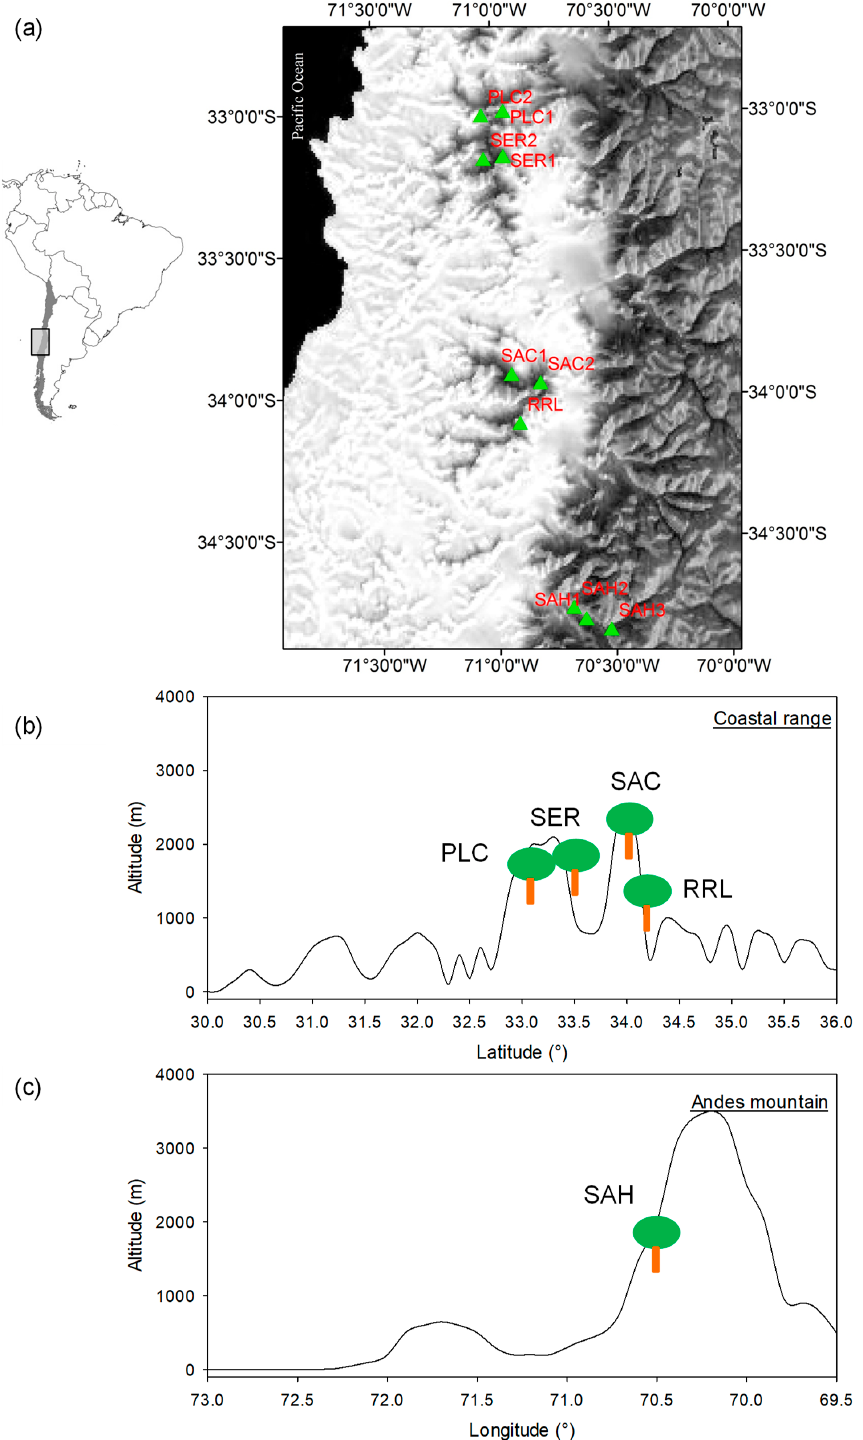
Figure 1. ( a ) Study area of N. macrocarpa sites sampled in this work. The populations represent the whole natural geographical distribution of N. macrocarpa in Chile (Amigo and Rodriguez-Guitan 2011). The digital elevation model shows the shape of the terrain (white showing the lowest elevation). ( b ) Relative positions of sites at the Coastal range (PLC, SER, SAC, and RRL) according latitudinal profile (° S). ( c ) Relative position of site SAH corresponding to the Andes group, according longitudinal profile (° W).